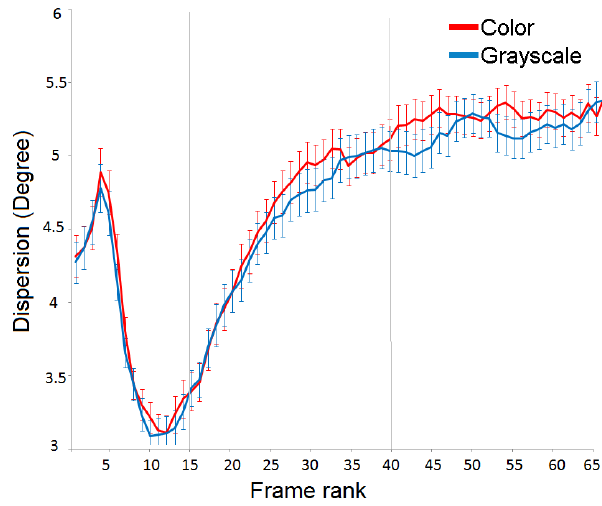
Figure 5 . Mean dispersion according to the stimulus condition (color and grayscale) in degrees of visual angle across time (frame rank). Error bars represent the standard error (standard deviation divided by the root square of the number of